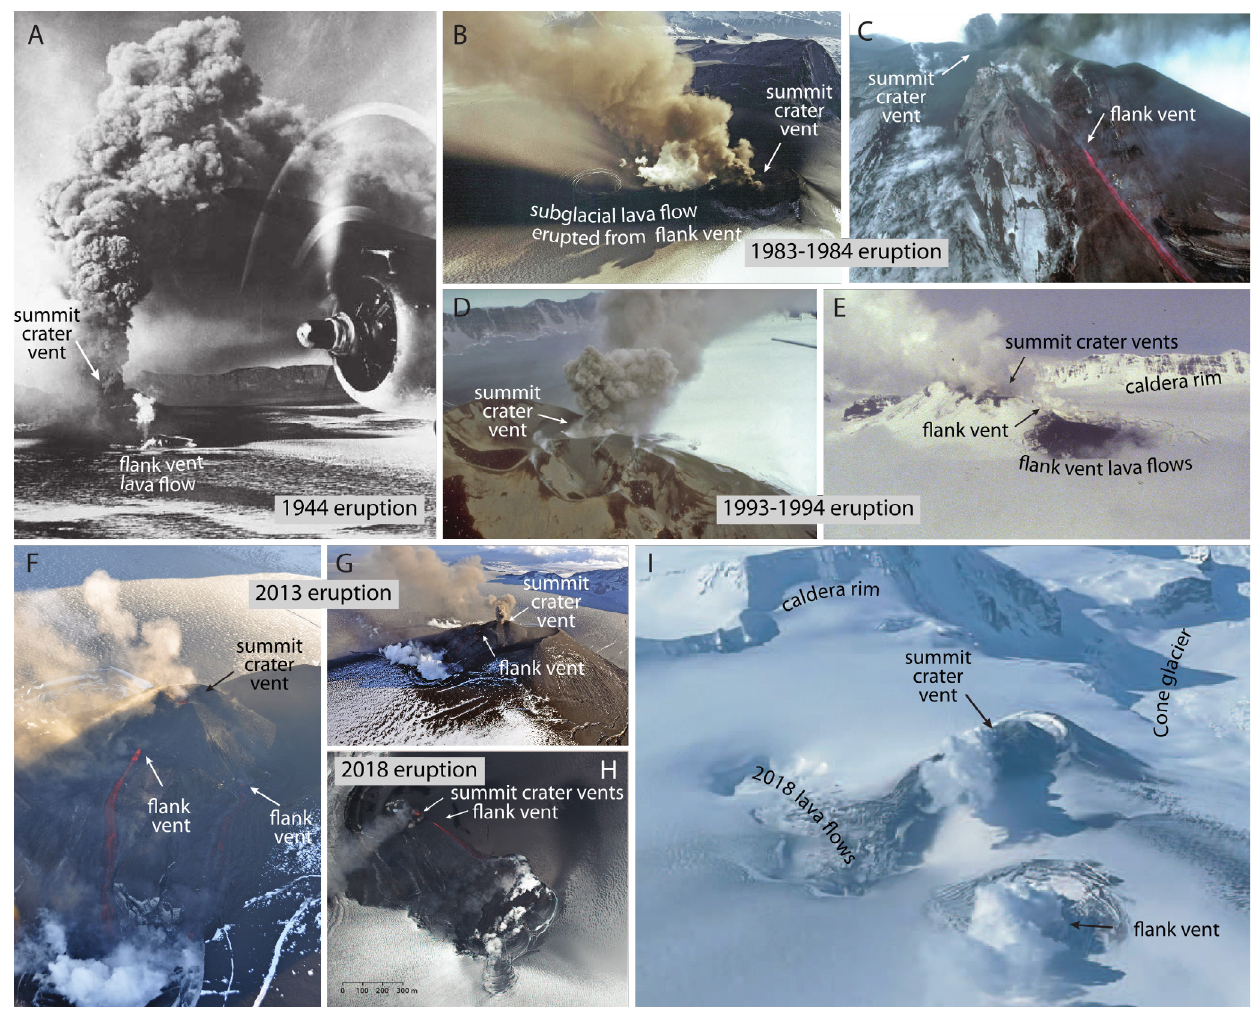
Figure 2: Representative photographs of the historically active intracaldera cone within the ice-filled caldera of Veniaminof Volcano showing simultaneous emission of ash and lava. [A] Ash emissions from summit vent and lava flow and melt depression at base of cone A, 1944. Photographer unknown. View is toward the north. [B] Ash emissions from summit vent and subglacial extrusion of lava from flank vent. June 6, 1983. Photo courtesy of Quantum Spatial. View is toward the west. [C] Simultaneous lava effusion and ash emission at cone A, October 7, 1983. Photo by E. Yount, USGS. View is toward the northeast. [D] Low-level Strombolian ash emission from the summit crater of cone A, August 3, 1993. Photo by D. Sellers, Alaska Department of Fish and Game. View is toward the southeast. [E] Oblique aerial photograph of cone A taken on fixed-wing aerial overflight, May 9, 1994 showing minor emissions at summit and flank vent lava flows. Photo by C. Nye, AVO. View is toward the north. [F], [G] August 18, 2013. Photos by R. McGimsey, USGS-AVO. Both views are toward the southwest. [H] September 26, 2018. Photo by M. Laker, US Fish and Wildlife Service. View is approximately vertical. [I] March 11, 2021. Although ash emission is obscured by vapor in this photograph, the summit vent was the only source of ash emission during the 2021 eruption. No other close-in photographs of the eruption are available. Photo by B.D. Jacob. View is toward the